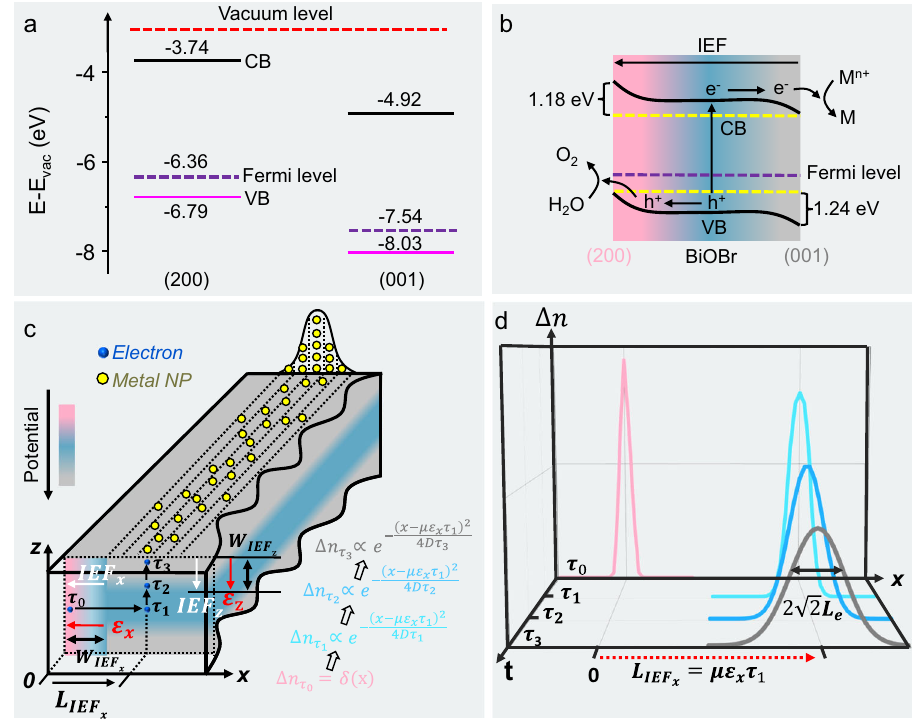
Fig. 4 The mechanism of charge separation and transfer. a Schematic diagram of electronic band structures for (200) and (001) facets by DFT calculations. CB: conduction band, VB: valence band. b Schematic illustration of the migration pathway of photogenerated electrons and holes within the (200)/(001) facet junction. c Schematic illustration of the cross-section of a platelet showing the migration pathway of photo-generated electron driven by two IEFs (horizontal and vertical). The directions of the intrinsic electric fi elds are denoted by red arrows. d The spatial distribution pro fi le of electrons at different time